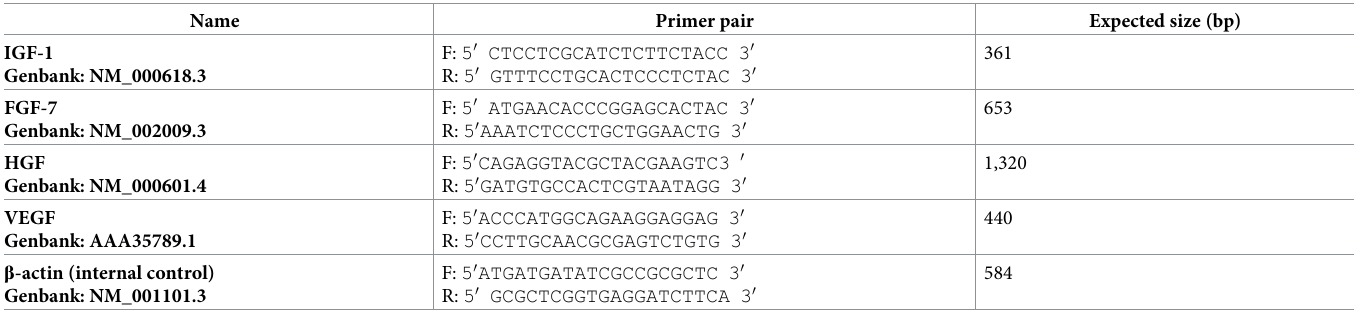
Table 2. Forward and reverse primers and the expected sizes of growth factors and β